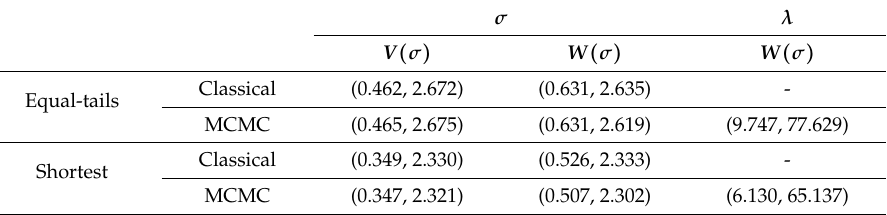
Table 3. CIs for σ and λ